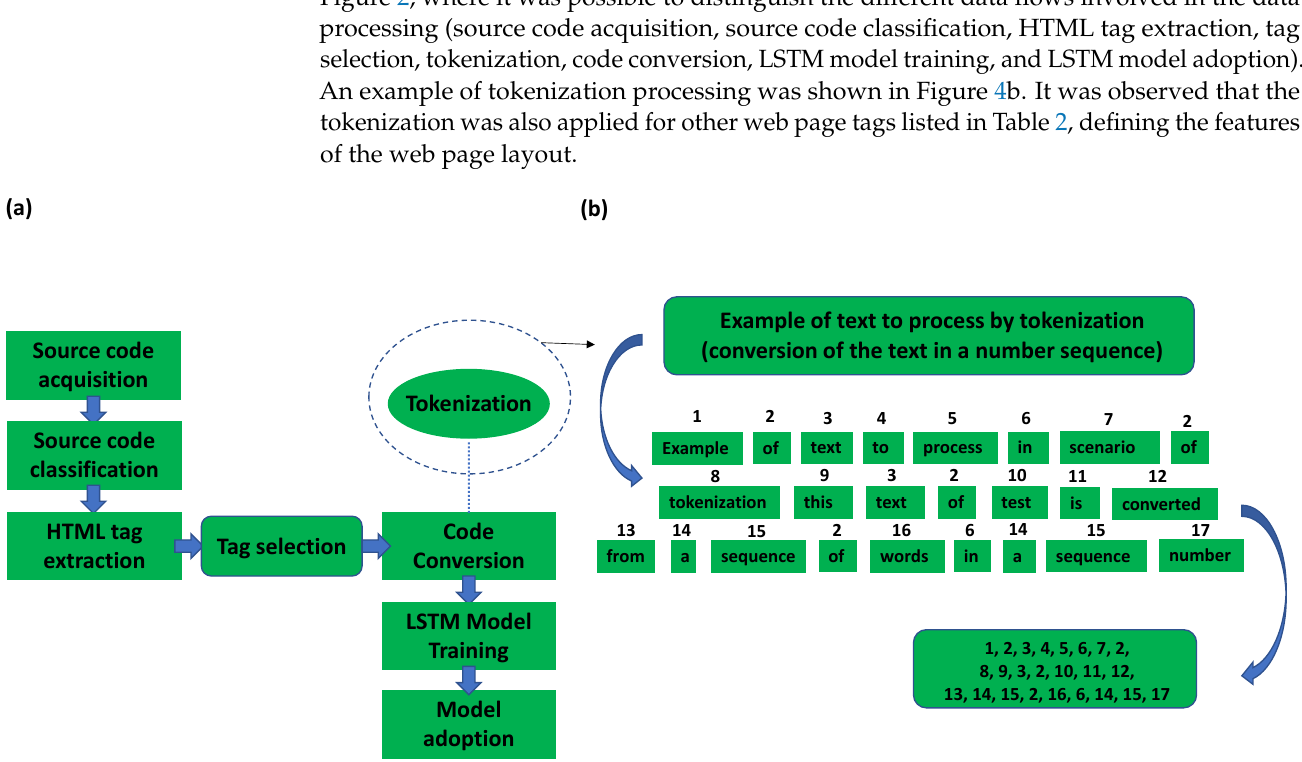
Figure 4. ( a ) Web page analysis and LSTM training approach. ( b ) Example of tokenization process “translating” a web page text into a sequence number.